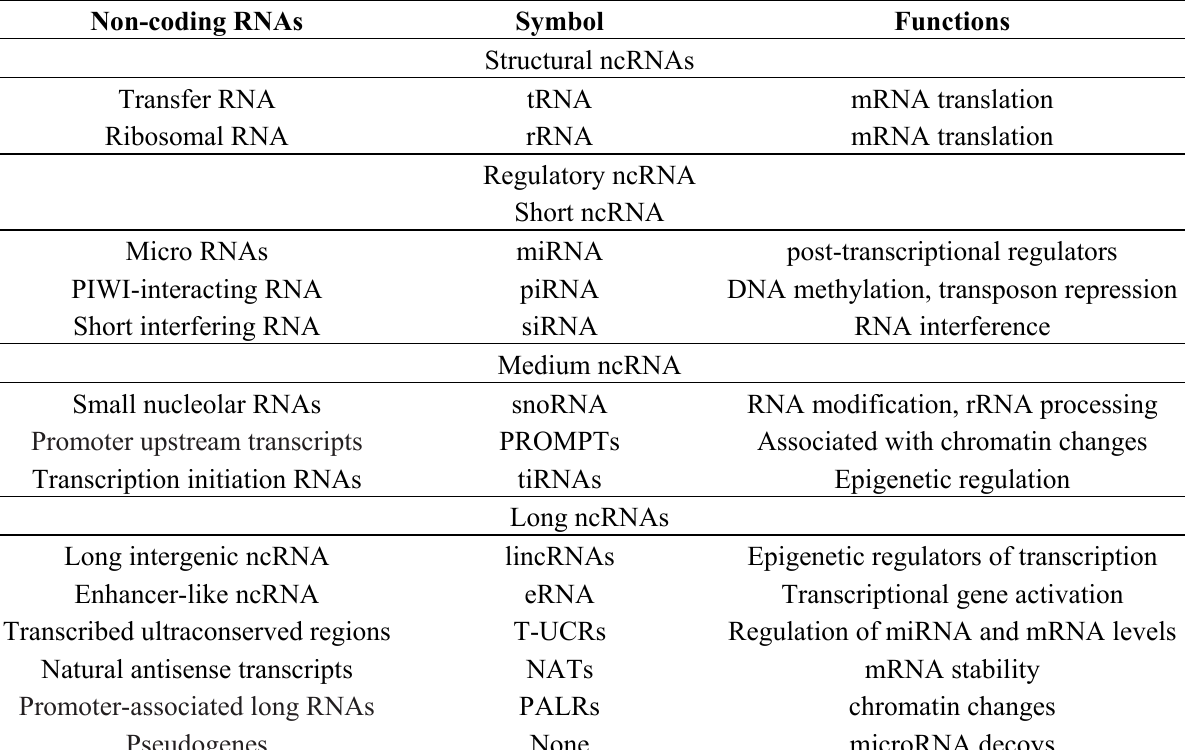
Table 1. Classes of non-coding RNAs (